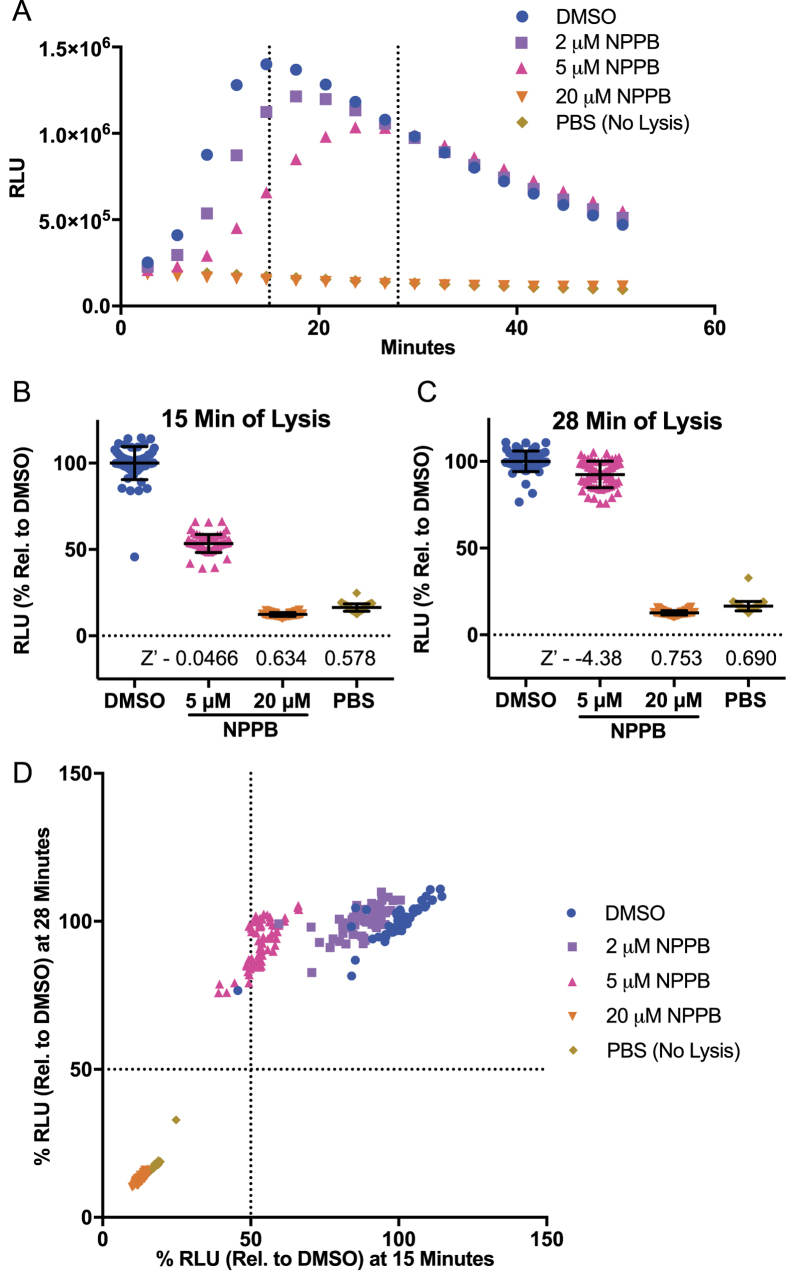
Establishment and validation of a Nanoluciferase (NLuc)-based high-throughput screening method of NPP inhibition.(A) Representative kinetic data from screening method. RBCs infected (iRBC) with Nluc expressing parasites were treated with NPPB prior to adding sorbitol to inhibit iRBC lysis and release of NLuc. DMSO vehicle (100% lysis) and PBS (sorbitol replacement, no lysis) controls are also shown. Dashed lines denote 15 and 28 minutes post sorbitol addition. (B and C) Relative light units (RLU) as a percentage relative to DMSO average at 15 (B) and 28 (C) minutes after addition of sorbitol for each drug treatment. Z′ values for each treatment are listed above the x-axis. (D) Graph of %RLU of NPPB and control-treated iRBC at 15 minutes versus 28 minutes post sorbitol addition.